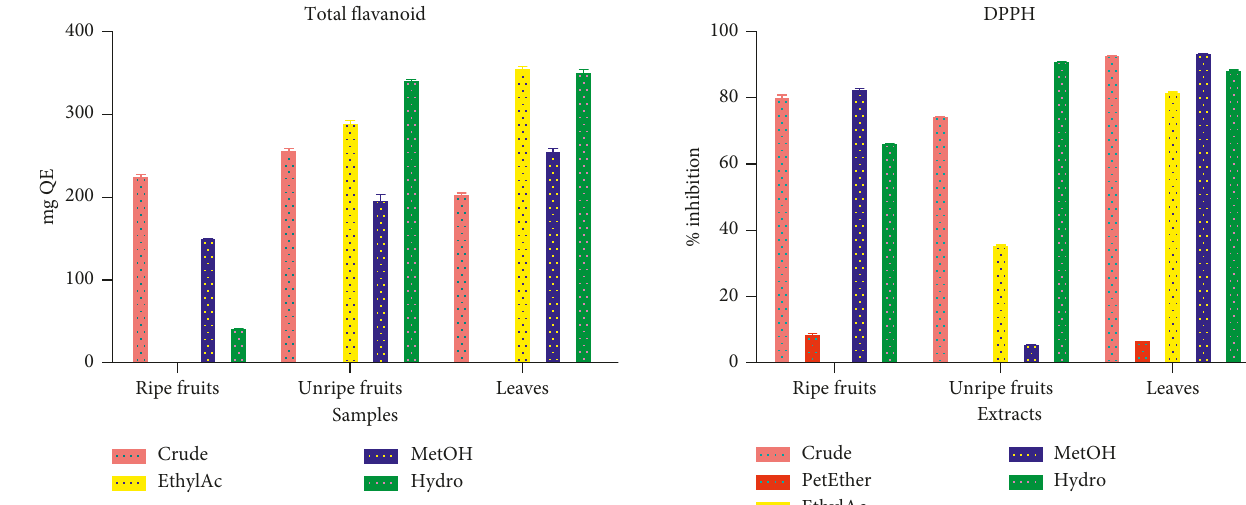
Figure 5: Total flavonoid content of extract and fractions of D. erecta .